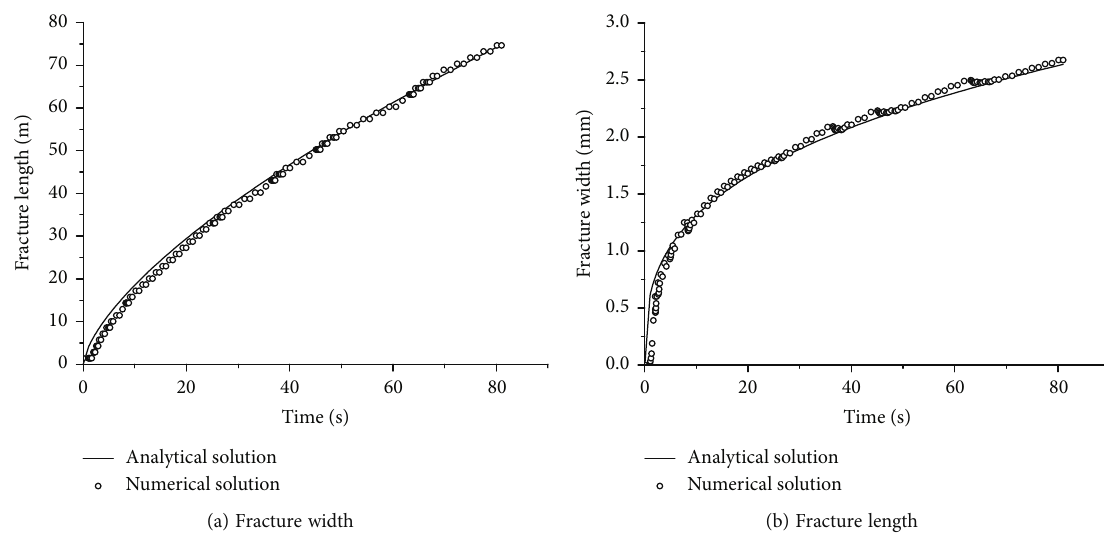
Figure 3: FE and analytical solutions of the fracking model.